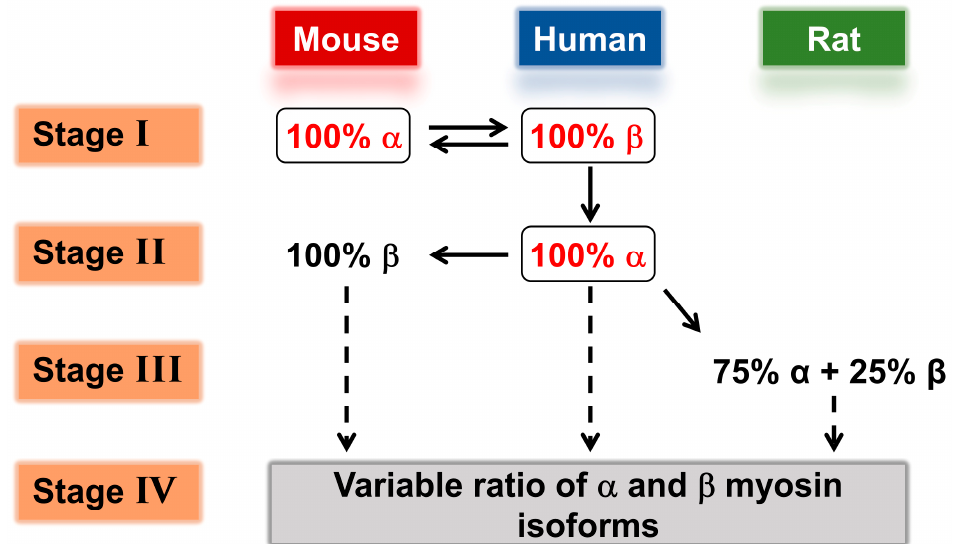
Figure 3. Procedure for modeling twitch contractions of different species. Stage I : Based on the previously published mouse twitch, adjusted for the conditions of Chung et al. [34], and the data of Deacon et al. [8] for the crossbridge cycle parameters of mouse α - and human β -myosins. Stage II : Based on Stage 1 and the data of Deacon et al. [38] on human α -myosin, which were then extrapolated to mouse β -myosin. Stage III : Based on the previous publication on the rat twitch (Mijailovich et al. [1]) and interpolating the crossbridge values for rats between those of mice and humans. Stage IV : Using the crossbridge parameter values derived in Stages 1–3 to predict the effect of variable ratios of α - and β -myosin in each case.